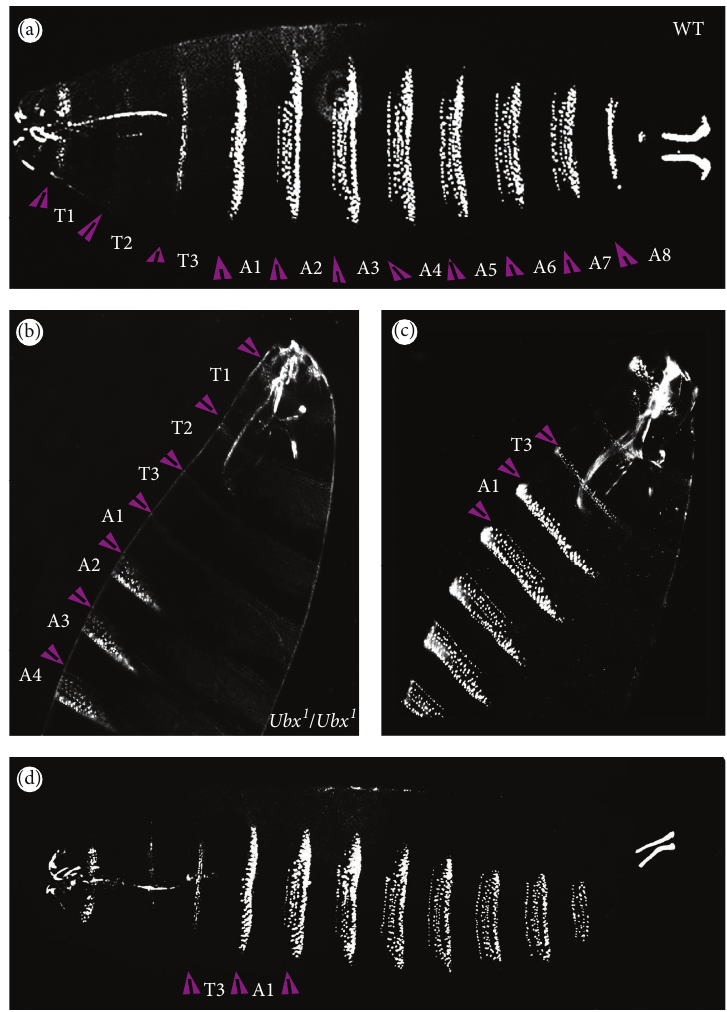
Figure 7: Cuticle patterns of embryos carrying Ubx-YFP protein trap. (a) Wild type embryo. (b) A diagram showing that both T3 and A1 segments are transformed into T2 in a Ubx loss of function mutant. Both transformed segments show T2-like denticle patterns. ((c) and (d)) Different views of Ubx-YFP embryos. Denticle bands of T3 and A1 segments are normal in Ubx-YFP embryos. Purple arrowheads indicate the